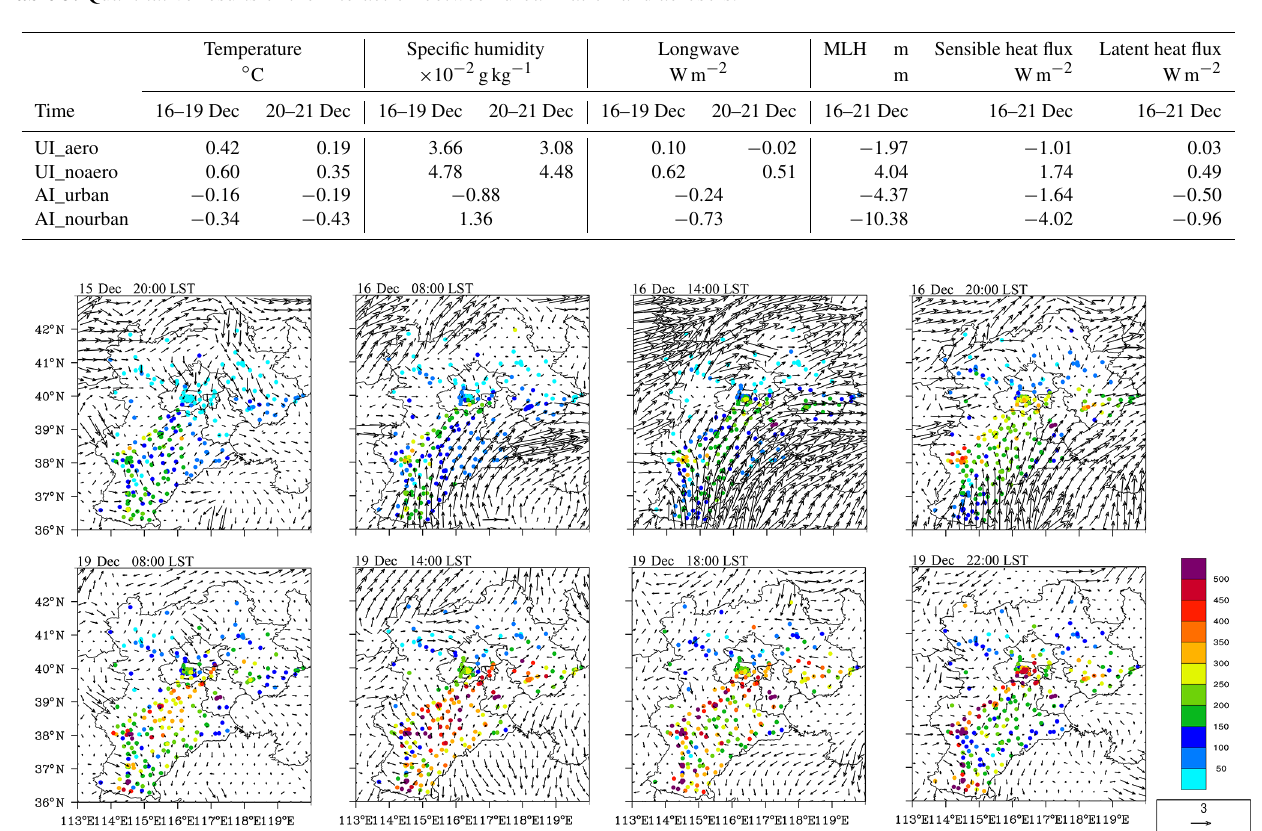
Table 3. Quantitative results of the interaction between urbanization and aerosols.